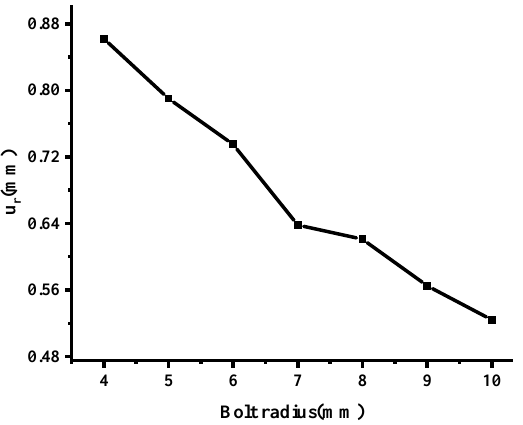
Figure 11. Relationship between bolt radius and radial displacement u r of rock joints.